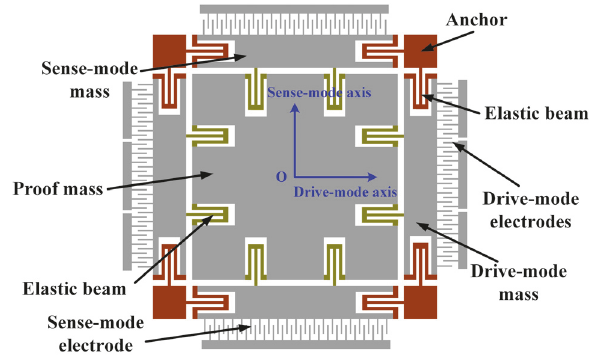
Figure 1: The schematic of the simulated